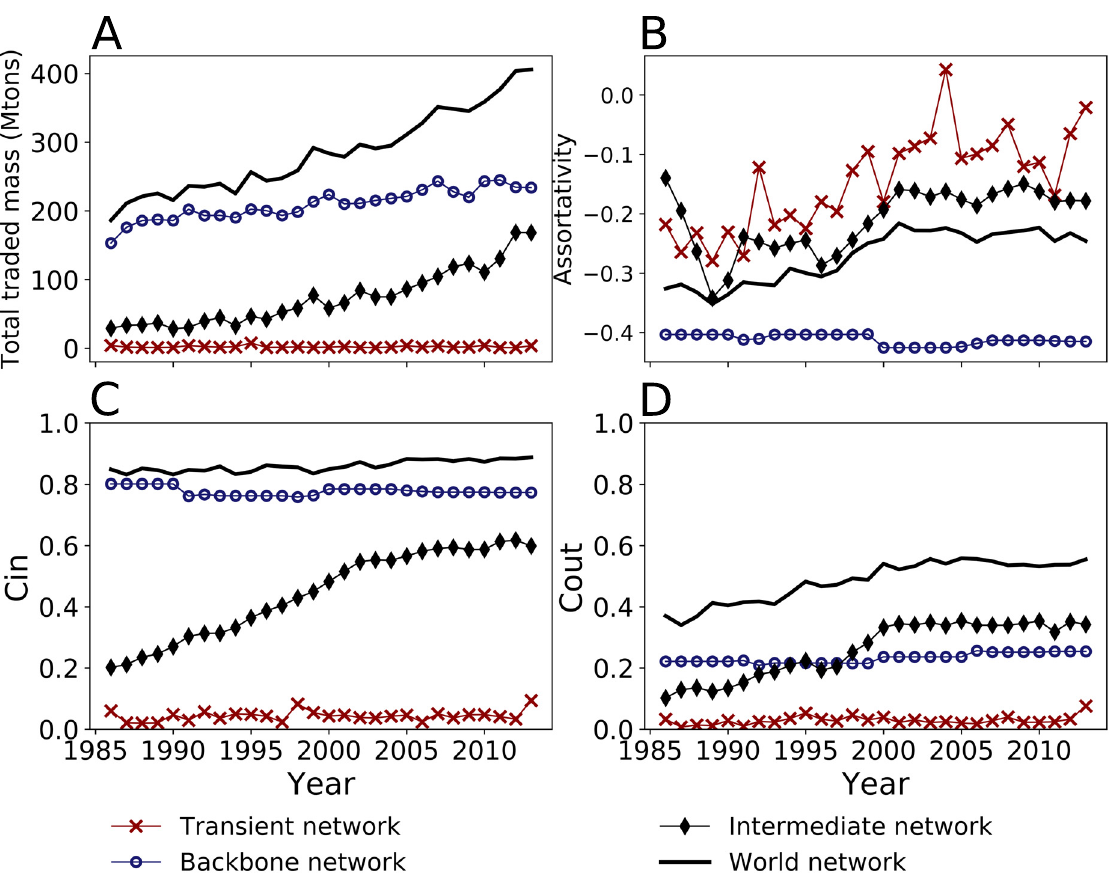
Fig 5. Evolution of the metrics of the total cereal network and the three subnetworks. A. Total traded mass. B. Assortativity coefficient. C. Clustering coefficient of type In. D. Clustering coefficient of type Out.